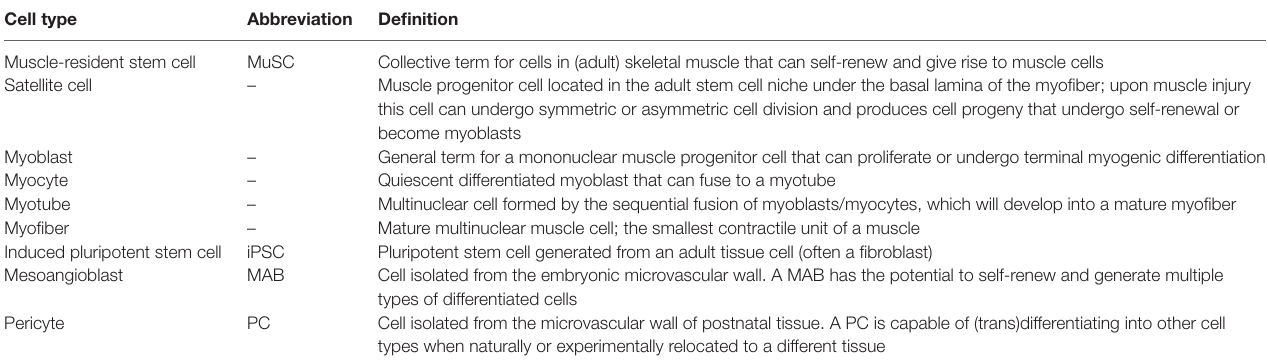
TAble 2 | Myogenic cell